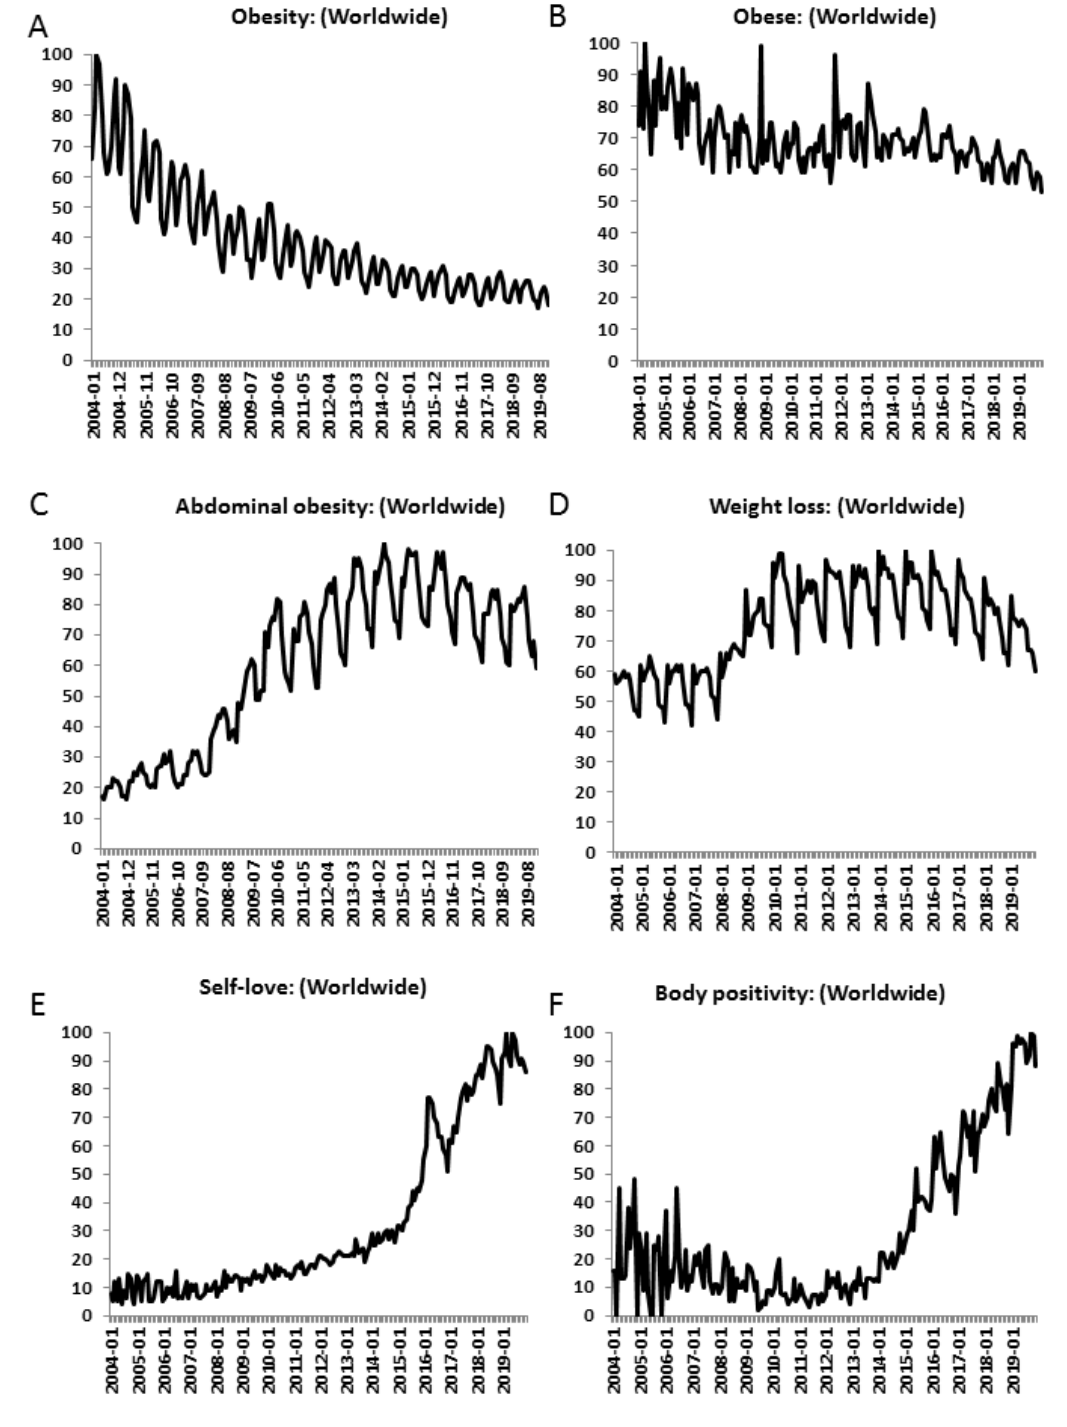
Figure 1. Comparison of the relative interest scores of the obesity-related search terms and topics during the study